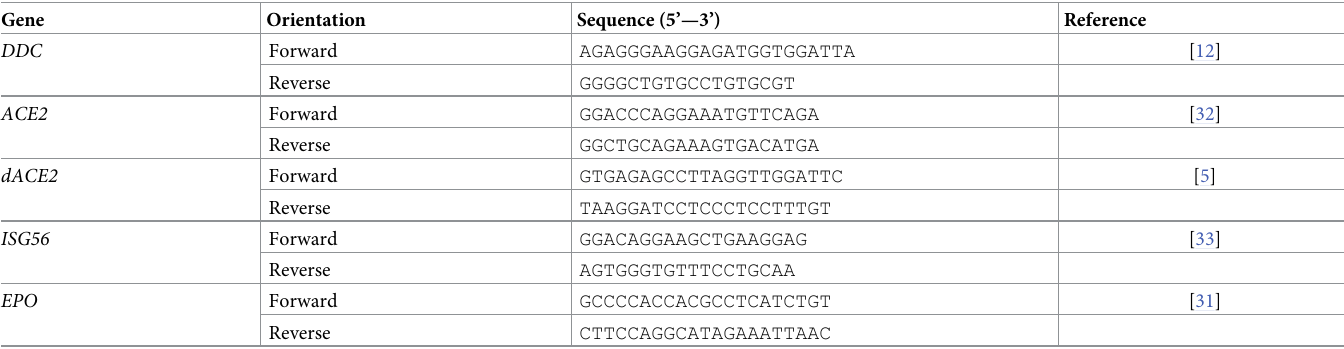
Table 1. Priming oligonucleotides used for RT-qPCR analysis.